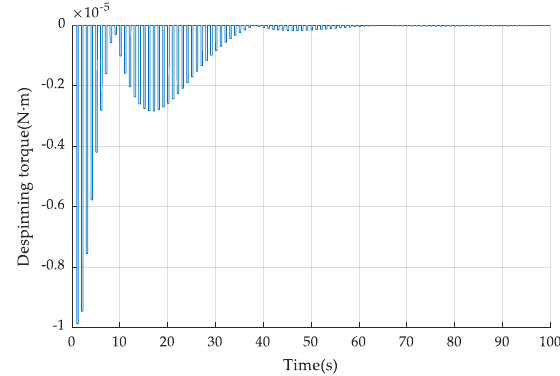
Figure 15. Eddy current torque curve in conventional mode.